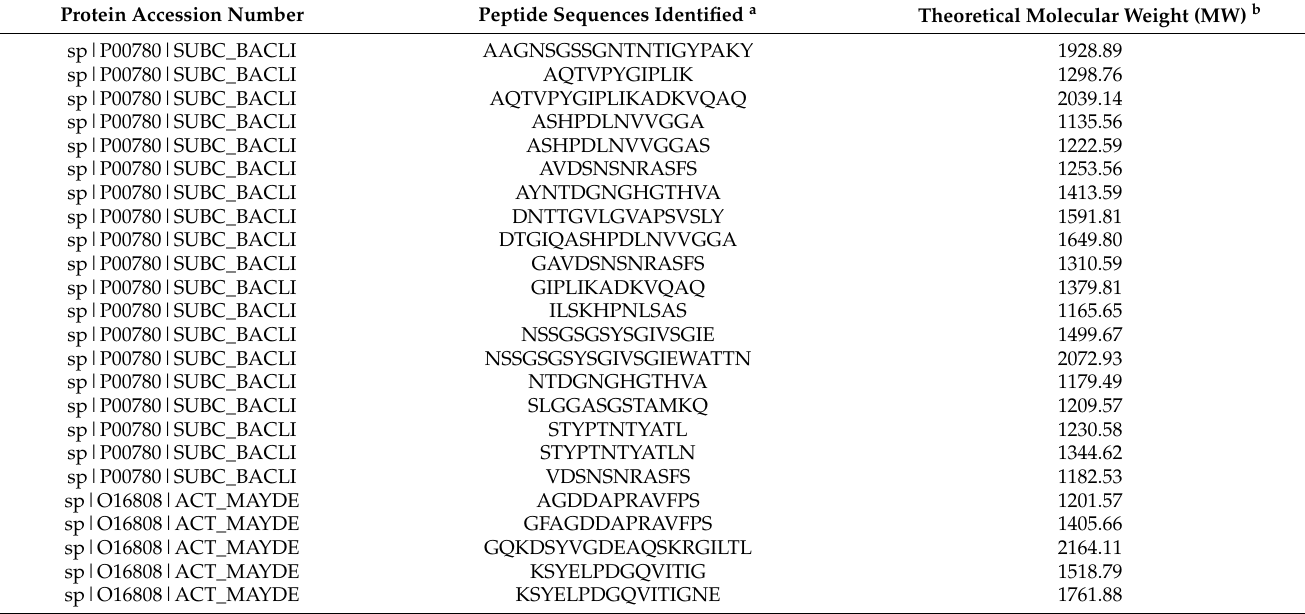
Table 1. Identification of snail hydrolysate sequences of peptides by mass spectrometry in tandem using the Uniprot Mollusca database (201,001, 340,255 proteins). Protein Accession